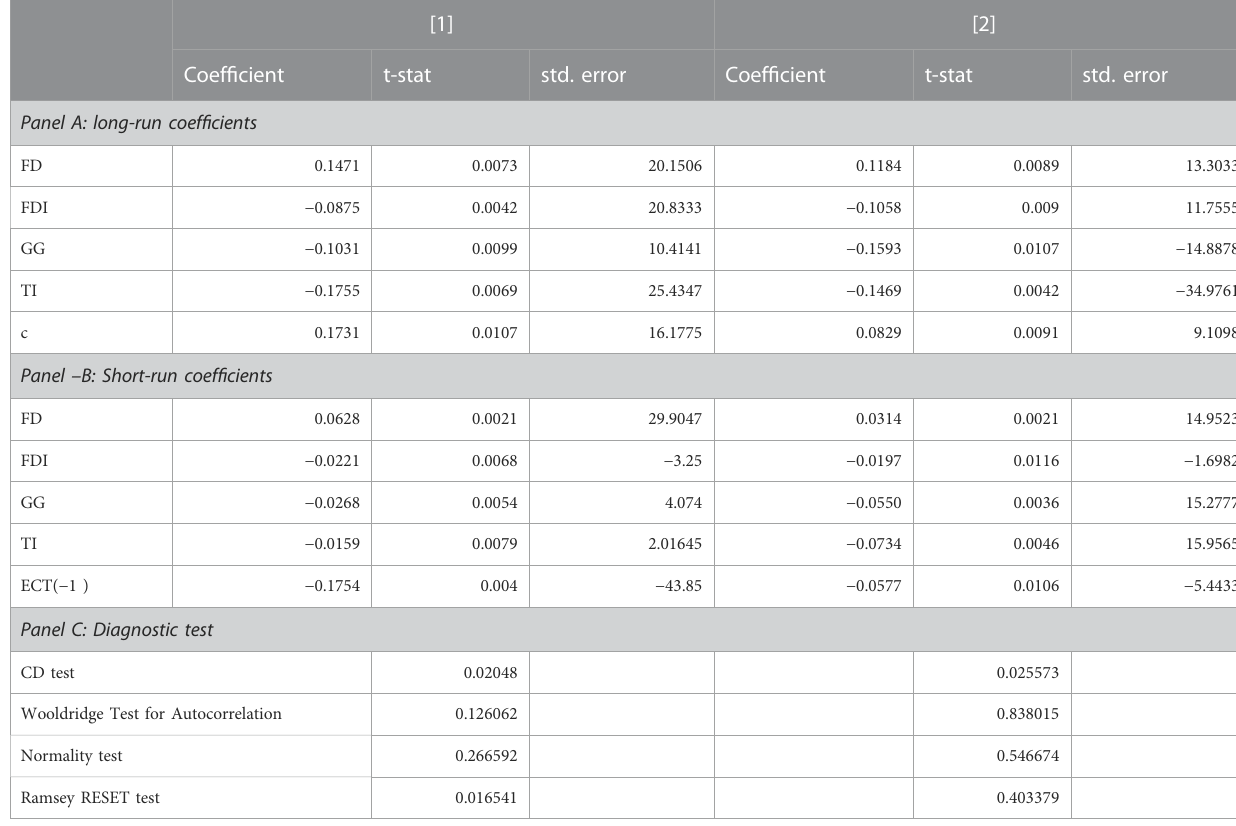
TABLE 10 Results of